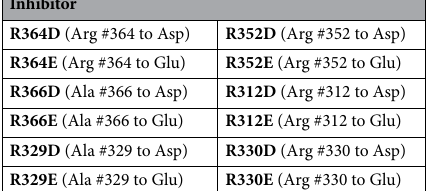
Table 2. Arginine (Arg/A) amino acid